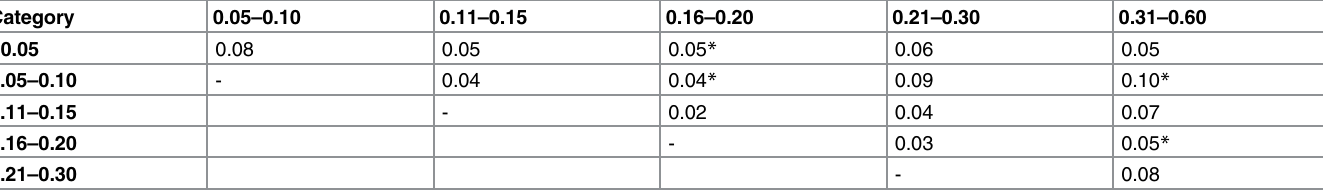
Table 5. Genetic differentiation of pepper lines when grouped by pericarp thickness (cm). Category